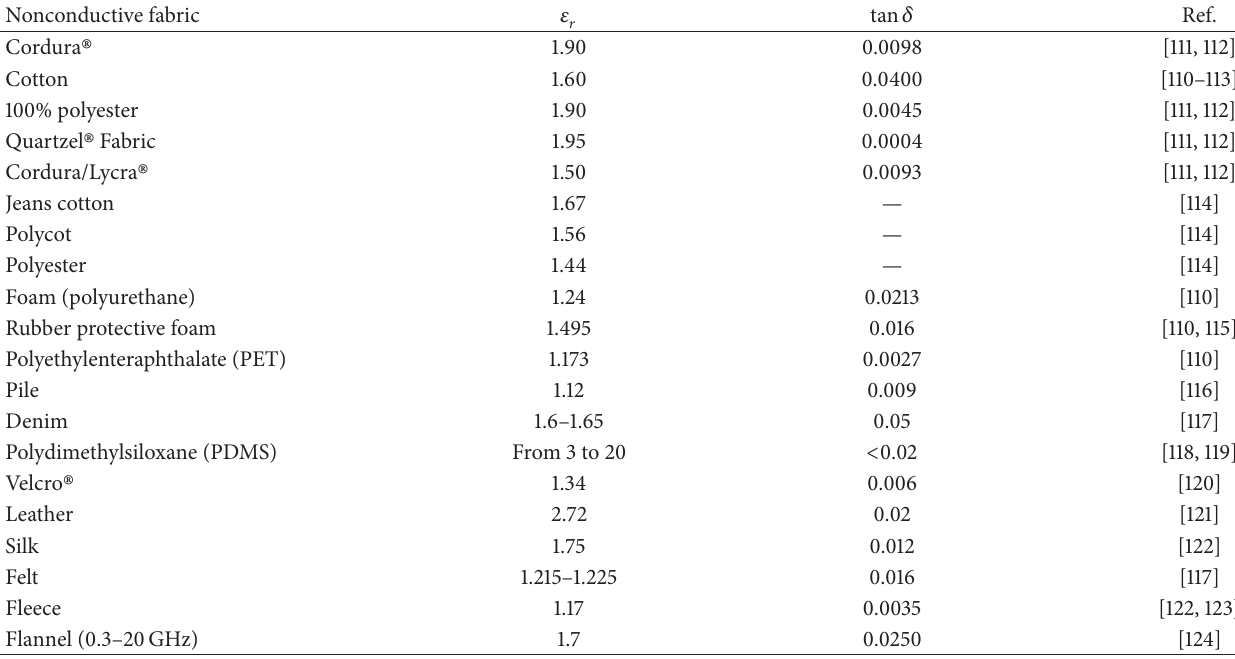
Table 2: Nonconductive fabrics characteristics.